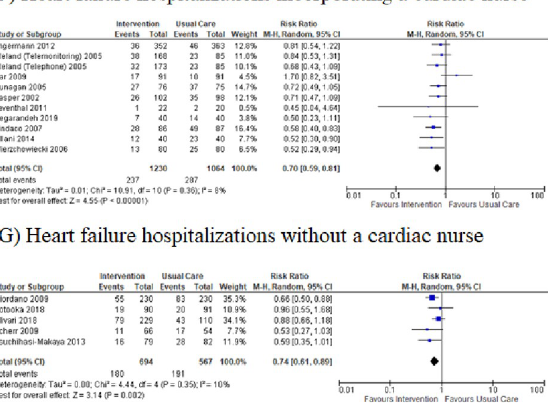
Fig 3. Subgroup analysis–presence and absence of a cardiac nurse in heart failure studies. https://doi.org/10.1371/journal.pone.0249542.g003 PLOS ONE | https://doi.org/10.1371/journal.pone.0249542 April 22,